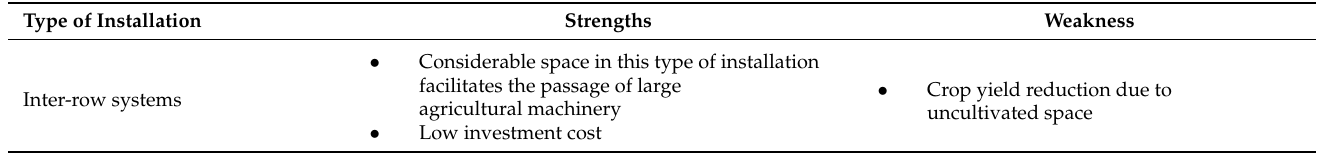
Table 1. Summary of the strengths and weaknesses of the different installations.